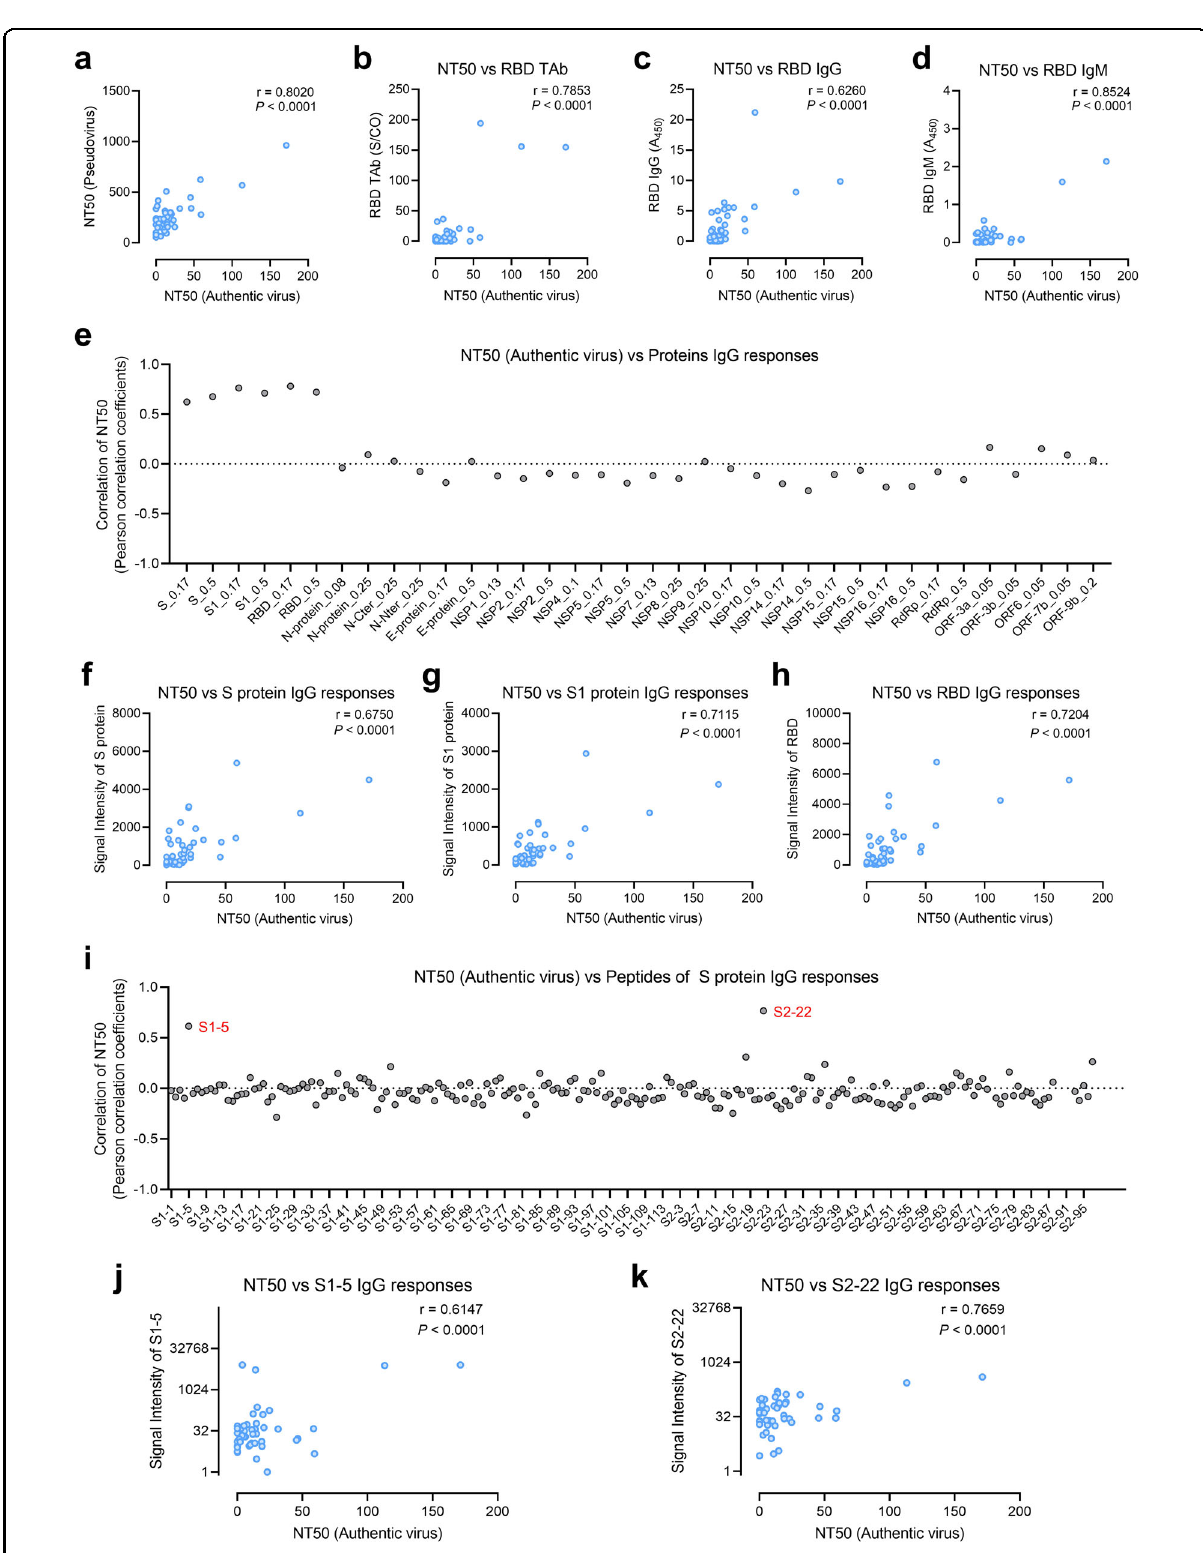
Fig. 4 Correlations between neutralization titers (authentic virus) and IgG responses to SARS-CoV-2 proteins or peptides. a Correlation of the NT50 (authentic virus) and NT50 (pseudovirus). b – d Correlations of the NT50 (authentic virus) to ELISA-based assays, i.e., anti-RBD total antibody (TAb, i.e., IgG, IgM, and IgA) ( b ), anti-RBD IgG ( c ), and anti-RBD IgM ( d ). e Correlation coef fi cients for the NT50 (authentic virus) and IgG responses to the SARS-CoV-2 proteins. f – h Correlation of the NT50 (authentic virus) to IgG responses against the S protein ( f ), S1 subunit ( g ), and RBD ( h ). i – k Correlation of the NT50 (authentic virus) to IgG responses to all the 197 peptides ( i ), and speci fi cally to S1-5 ( j ), and S2-22 ( k